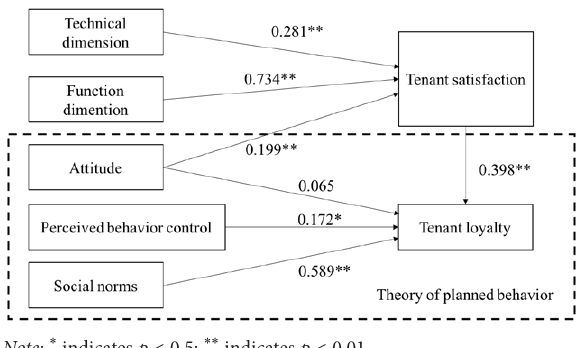
Figure 2. The theoretical structural equation model